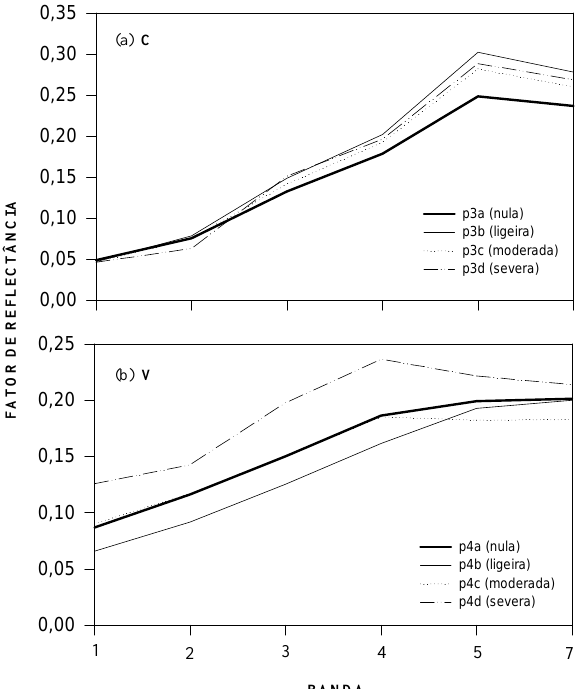
Figura 6. Dados espectrais simulados do TM-LANDSAT do Cambissolo C (a) e Vertissolo V (b) designados por diferentes níveis de erosão. Bandas: 1, 450-520 nm; 2, 520-600 nm; 3, 630-690 nm; 4, 760-900 nm; 5, 1.550-1.750- nm; 7, 2.080-2.350